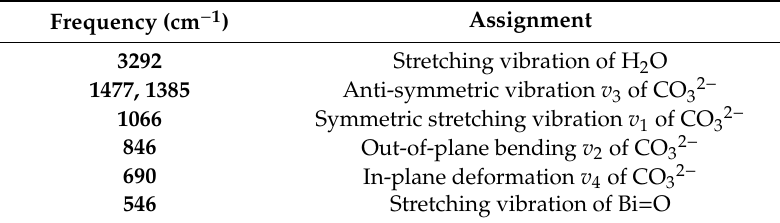
Table 1. Main absorption bands in the IR of the compound Bi 2 O 2 CO 3 :Al.